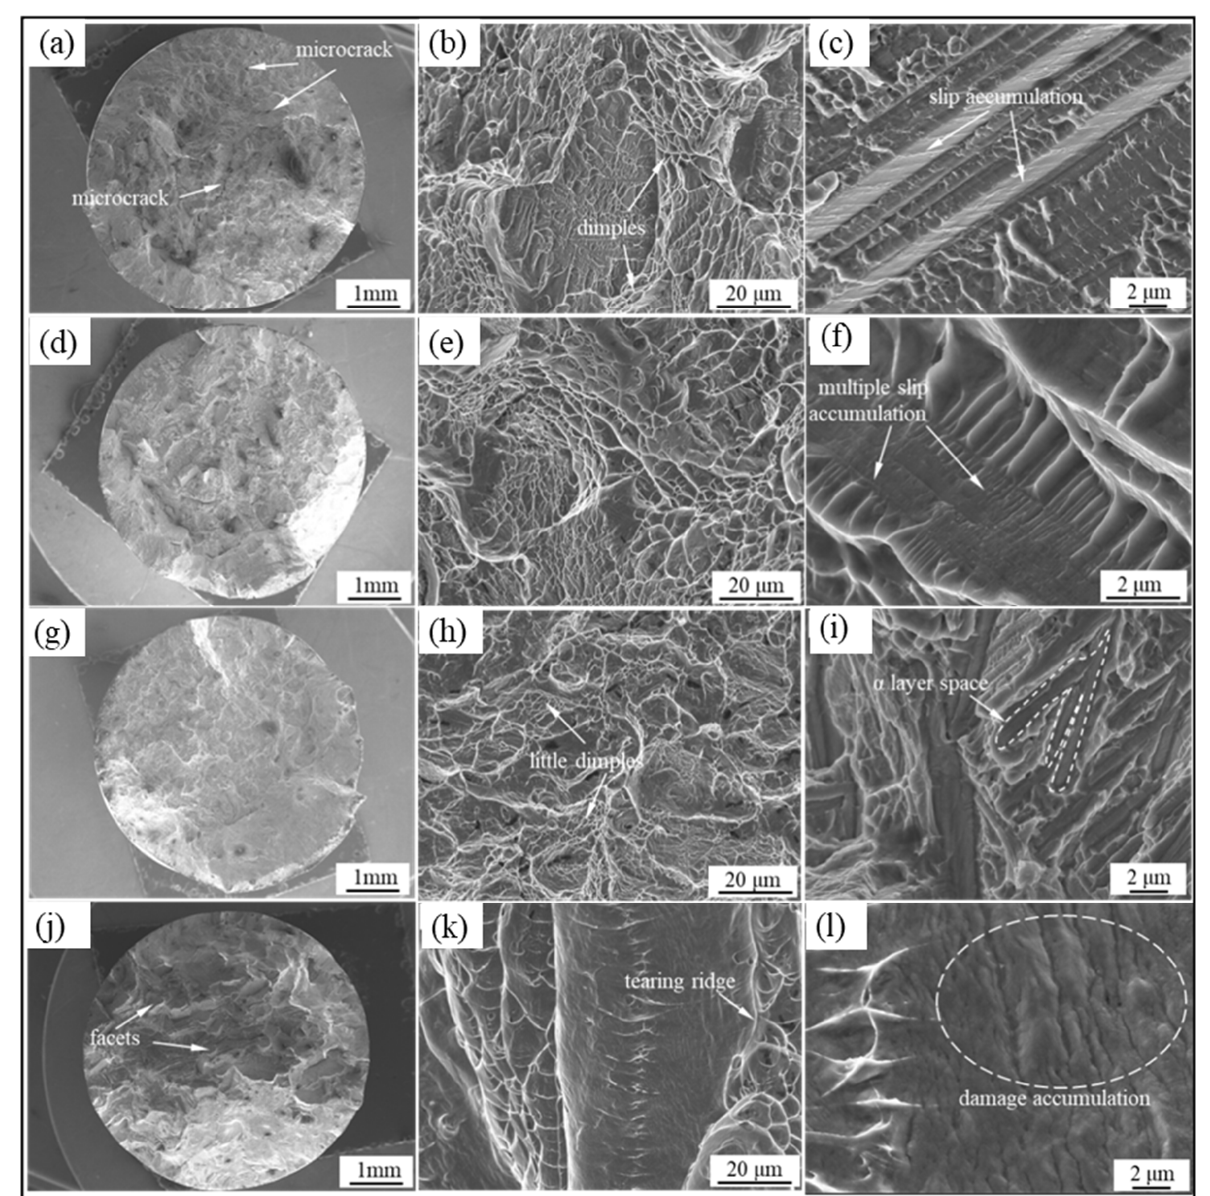
Figure 9. Fracture morphologies of sample: FC ( a – c ), OFC ( d – f ), AC ( g – i ), and WQ ( j – l ) at different cooling methods.